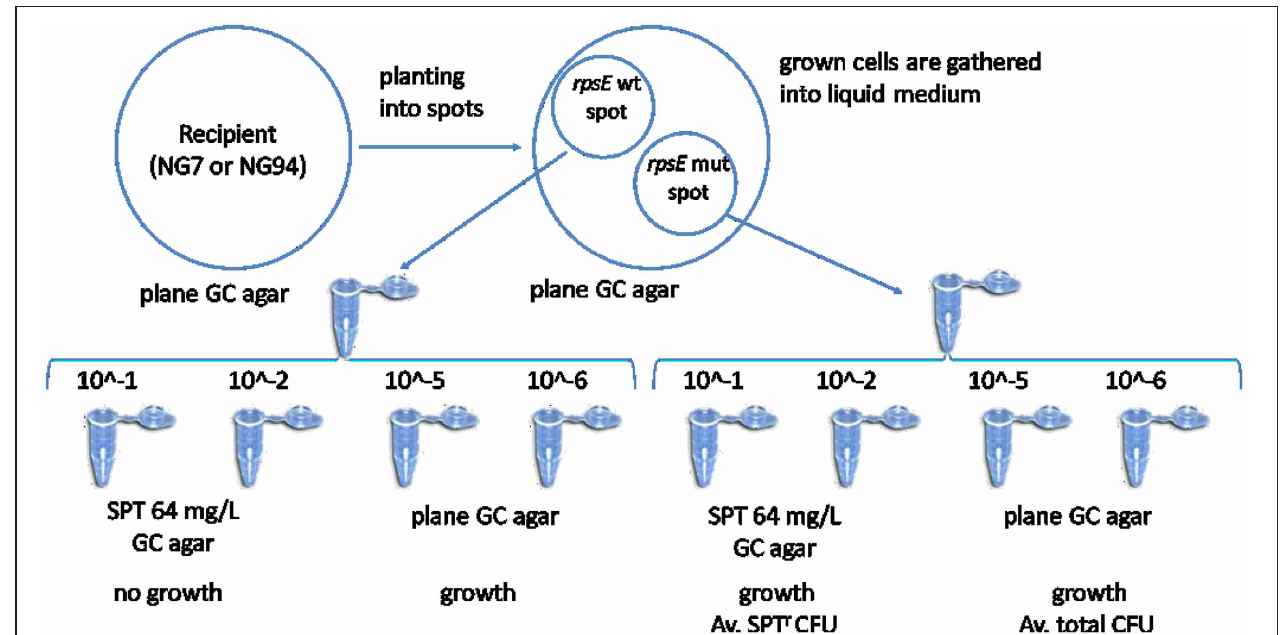
FIGURE 2 | The principal scheme of sport transformation. Amplified DNA fragments carried mutant (mut) and wild type (wt) of rpsE gene cording the ribosomal protein S5 (RPS5) were placed in spots on a GC base agar plate. Then piliated colonies of recipient strains (NG7 and NG94) were streaked across the plate through the DNA spots. After overnight incubation, bacterial